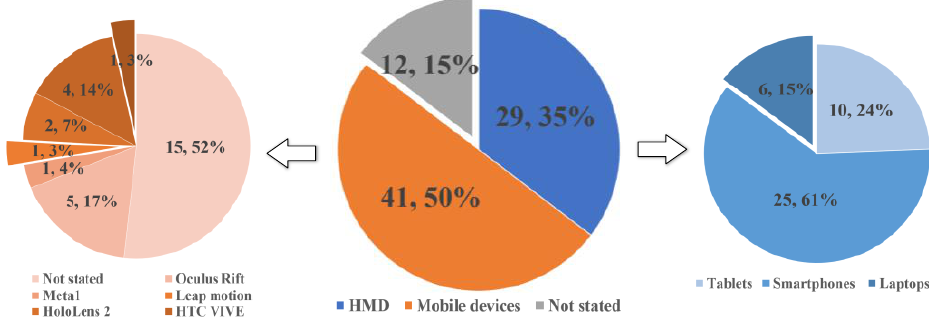
Figure 14. The percentage of applied AR/VR education and teaching devices.